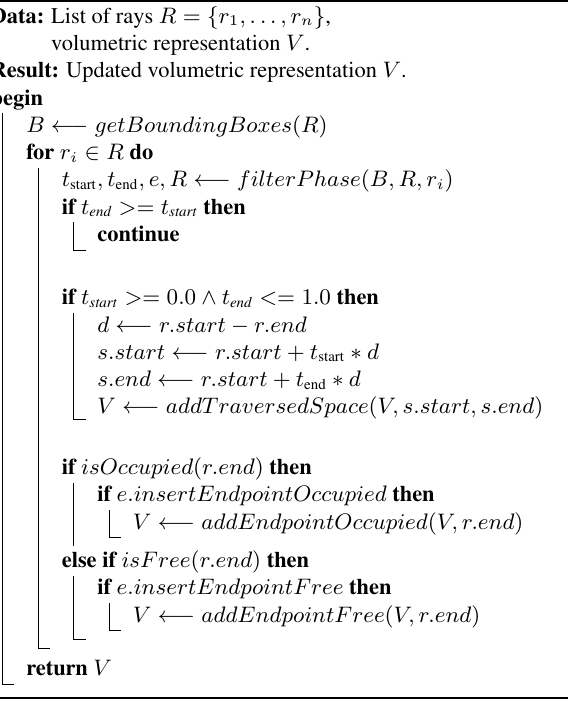
Algorithm 2: Filter phase of the plane-filtered raycasting. The ray in question is intersected with all